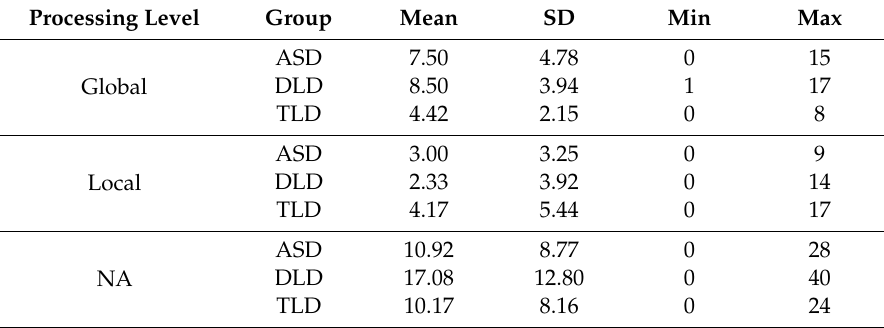
Table 3. Group semantic feature descriptive statistics by processing level.